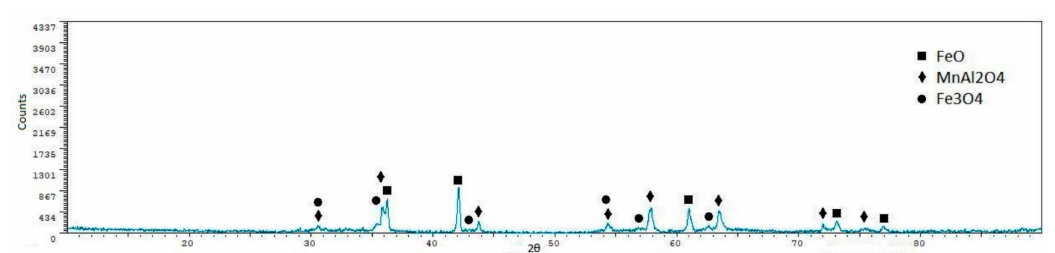
Figure 6. X-ray diffraction pattern of the sample Sint4.